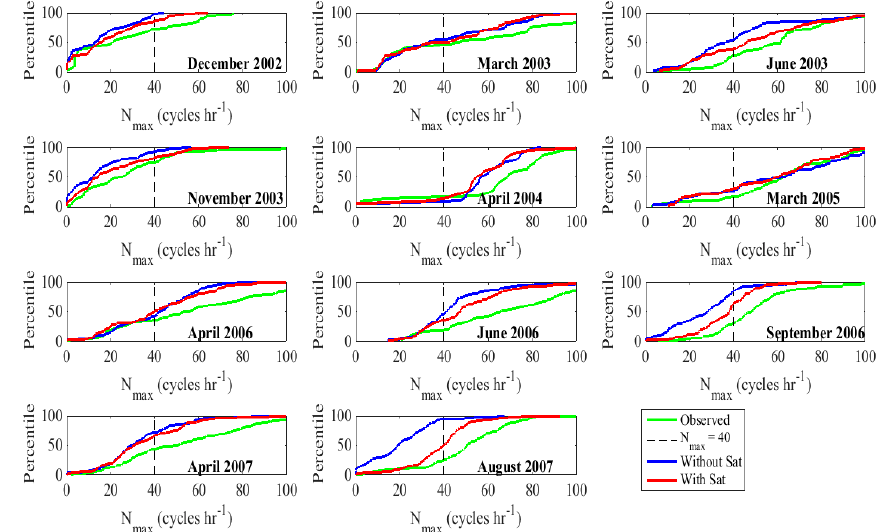
Figure 9. Cumulative distribution function of maximum buoyancy frequency (N max ), which is an index of the strength of vertical stratifications, for 12 cruises (20–90 stations occupied per cruise from December 2002 to August 2007. Observations (green) were compared to a reference model run without satellite data (blue) and a test model run with satellite data (red). The black dashed vertical line at N = 40 represents the buoyancy frequency at which hypoxia begins to occur [7].